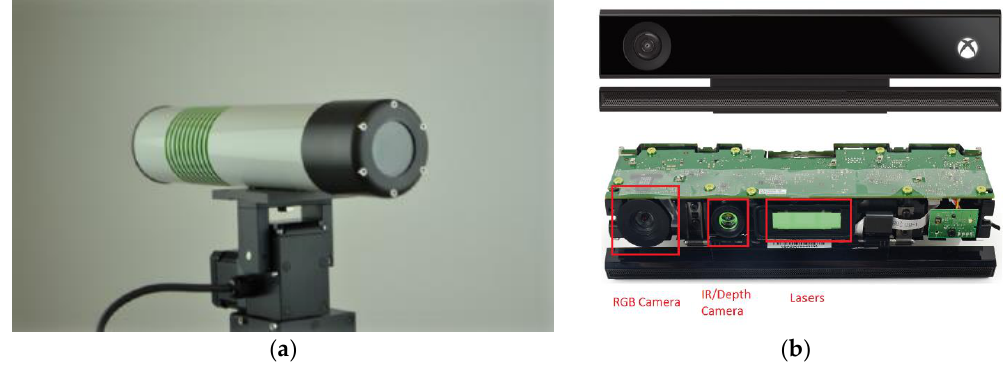
Figure 1. ( a ) Middleton Spectral Vision MSV 101 Hyperspectral Camera. ( b ) Kinect V2 depth sensors.